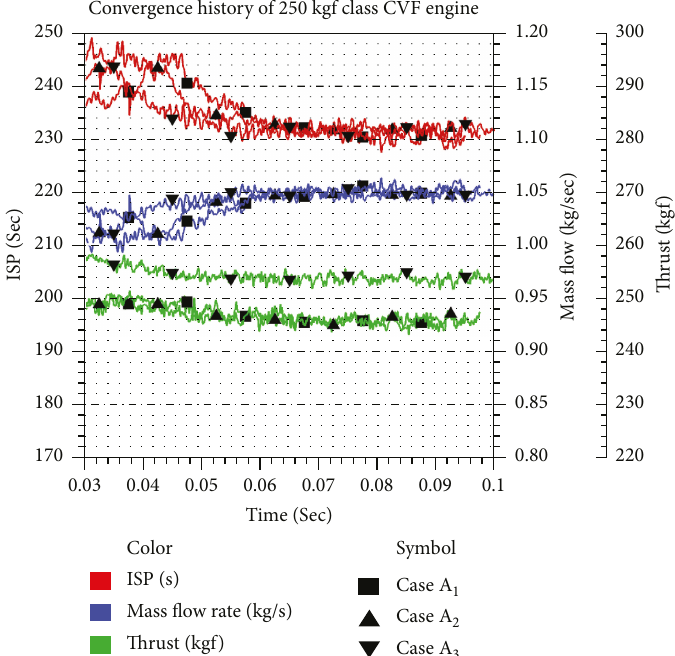
Figure 2: Convergence history of the numerical calculation of 250 kgf class DVF